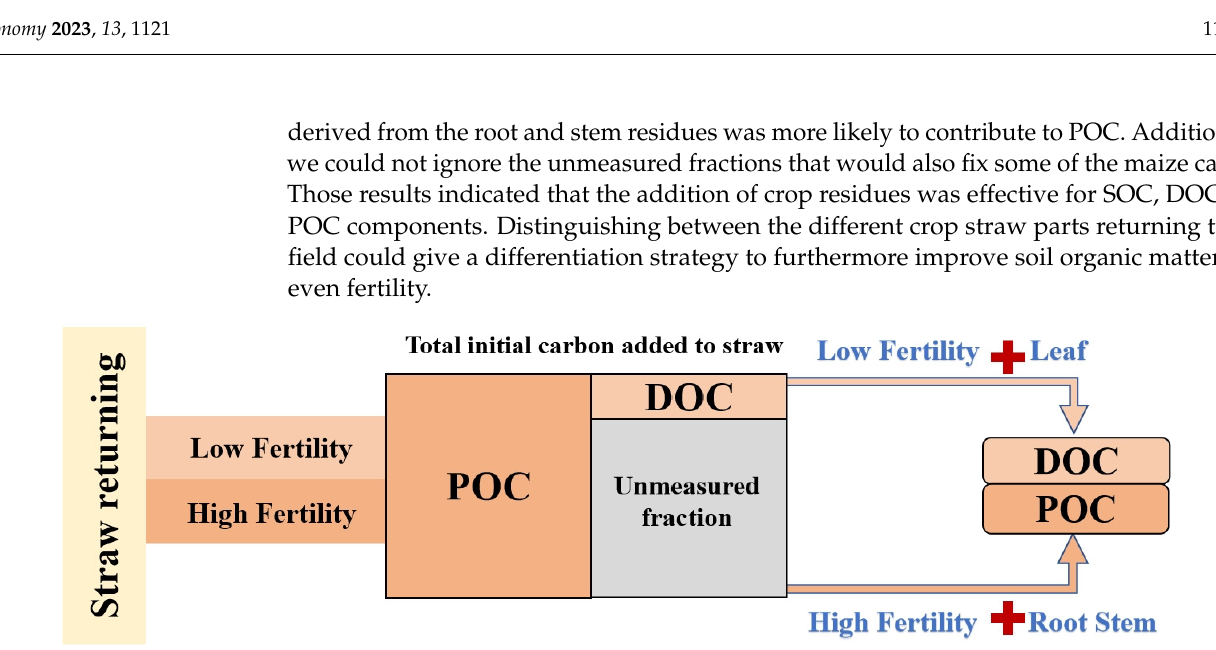
Figure 6. Changes of DOC and POC under di ff erent treatments over 540 days of the experiment. Author Contributions: J.P. proposed and designed the research. M.W. conducted experimental op- erations, analyzed statistics and wrote the manuscript. Y.Y. and S.W. assisted the test operation. J.P. reviewed the manuscript. All authors have read and agreed to the published version of the manu- script.